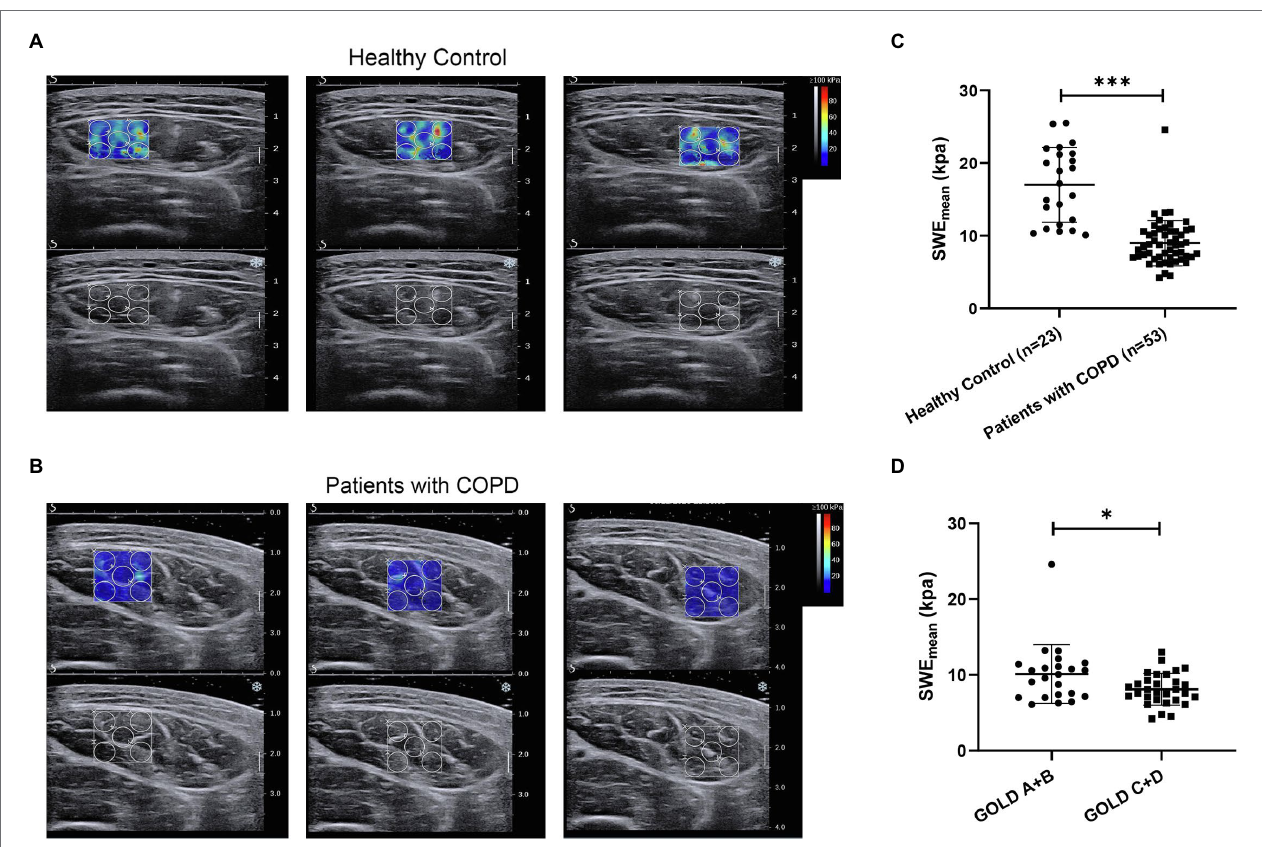
FIGURE 2 | The difference in the mean elasticity indices of rectus femoris ultrasound elastography in patients with chronic obstructive pulmonary disease (COPD) and healthy controls. (A) Representative SWE images of the rectus femoris and grayscale ultrasound images in healthy controls; (B) Representative SWE images of rectus femoris and grayscale ultrasound images in patients with COPD; (C) Difference in mean elasticity index (SWE mean ) in patients with COPD and healthy controls; and (D) Difference in SWE mean in patients with global initiative for chronic obstructive lung disease (GOLD) A and GOLD B and in patients with GOLD C and GOLD